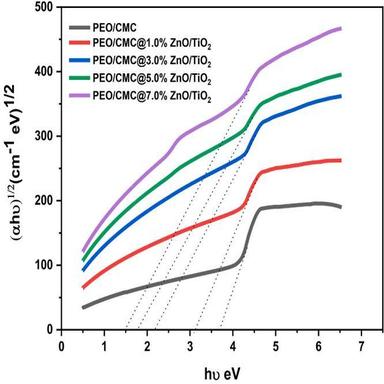
The dependence of (αh v) 1/2 ON (h v) for PEO/CMC blend and PEO/ CMC/ZnO/TiO2 NP at various concentrations.